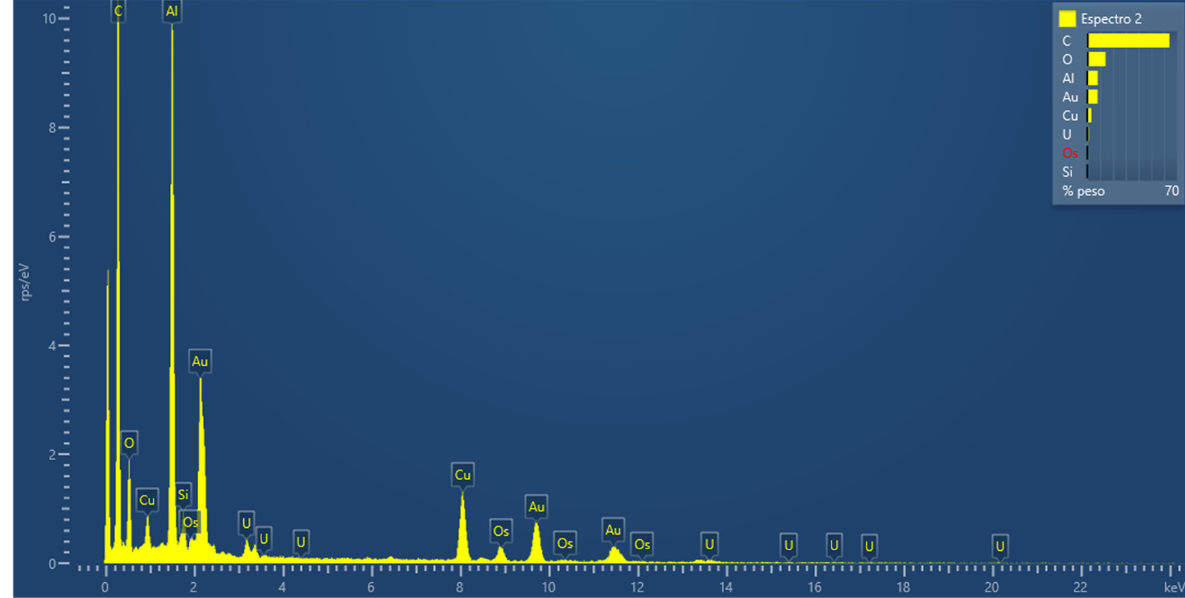
Figure 7. Microanalysis using energy dispersive spectroscopy, in an ultra-fine section of cells fixed, treated and cut in an ultramicrotome, to verify the presence of the gold nanoparticle in the sample.